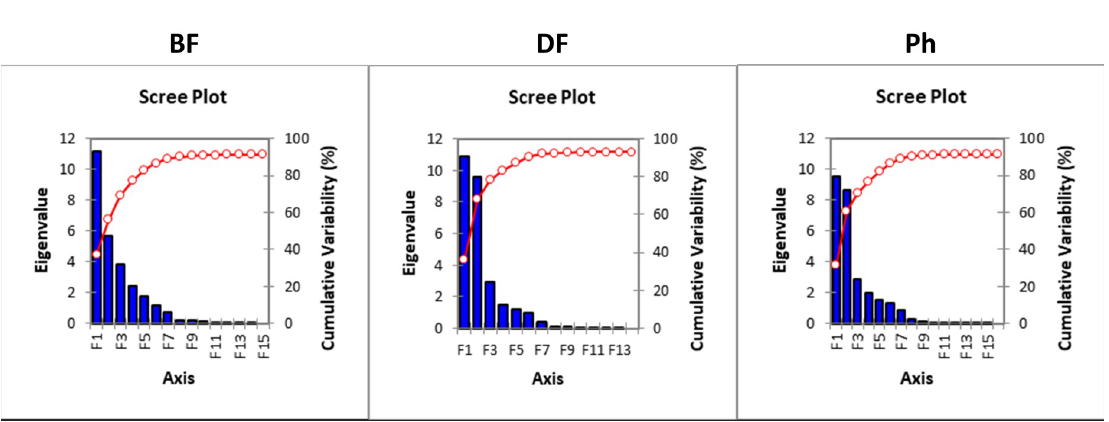
Fig 4. Scree plots of factor analysis for different microscopic techniques (BF-bright field, DF-dark field, Ph-phase